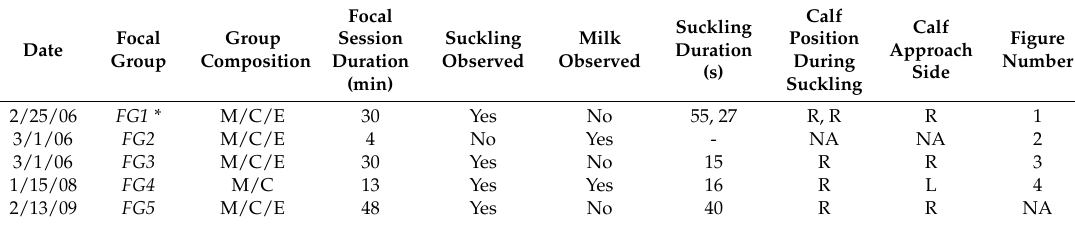
Table 1. Summary of nursing events and milk observations.